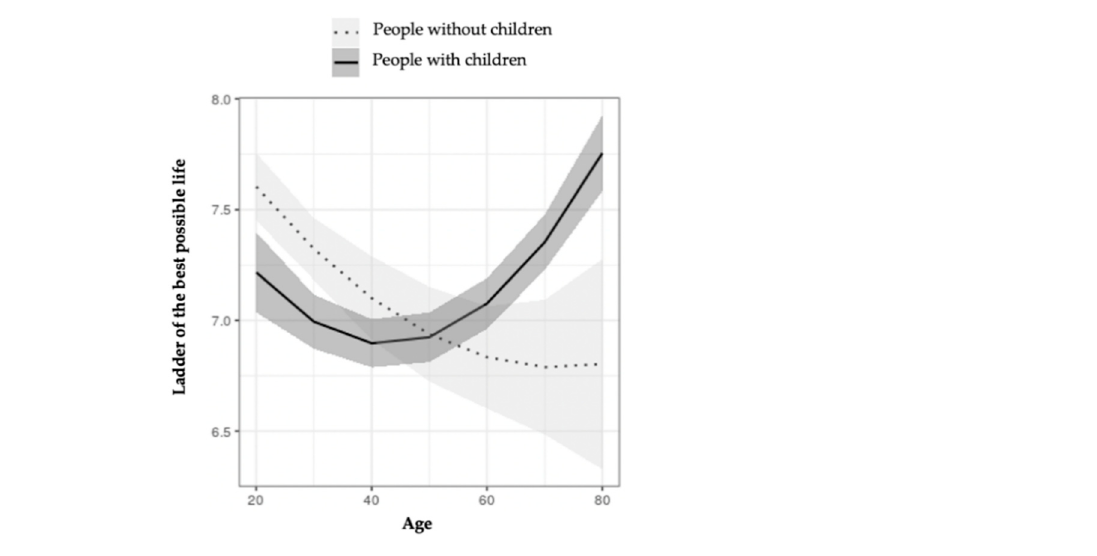
Figure 1. Moderation effect of age on the ladder of the best possible life in people with and without children.